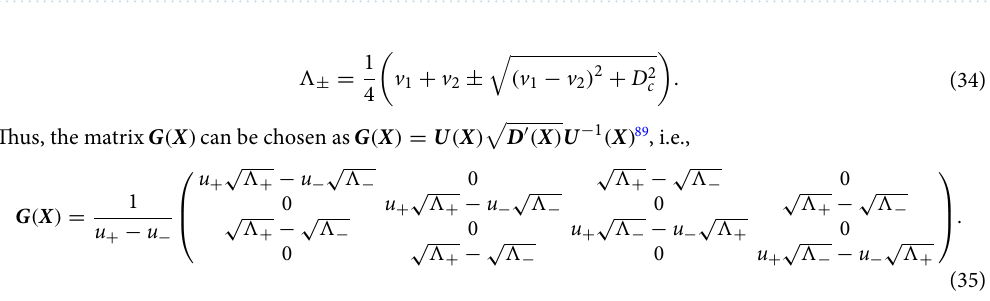
Figure 10. Characterization of the quantum regime: average photon numbers, nonuniformity, purity, and elements of the density matrix of a single unit vs. γ 2 . ( a ) Average photon number of unit 1. ( b ) Average photon ( x 1 x 2 ) 2 number of unit 2. ( c ) Root mean squared distance ( d ) Purity P . ( e – g ) Elements of the density � − � matrix of a single unit ρ 1 with respect to the number basis in the semiclassical ( e ), weak quantum ( f ), and strong (cid:31) 1 / 2 (red dots) and QME α j α ∗ quantum regime ( g ). In ( a – c ), results obtained from the semiclassical SDE j � α − � 1, 2 ) are shown, where α j α ∗ α j ( t )α ∗ ( t ) over a time a † a j (blue lines) ( j j j � α is calculated as a time average of j = (cid:31) (cid:30) � 0.6, θ 0.3 , D 0.99 , π , η interval of length 30000 after the initial transient. The parameters are � h = − = − = = 1 ( D 0.005 and D 0.995 ), and γ 1 0.1 ( e ), γ 2 0.5 ( f ), 2 γ 2 with γ 0.2 . In (e-g), γ 2 γ ′ 1 D c x = p = ′ 1 = = = = = + 3 ( g γ 2 =